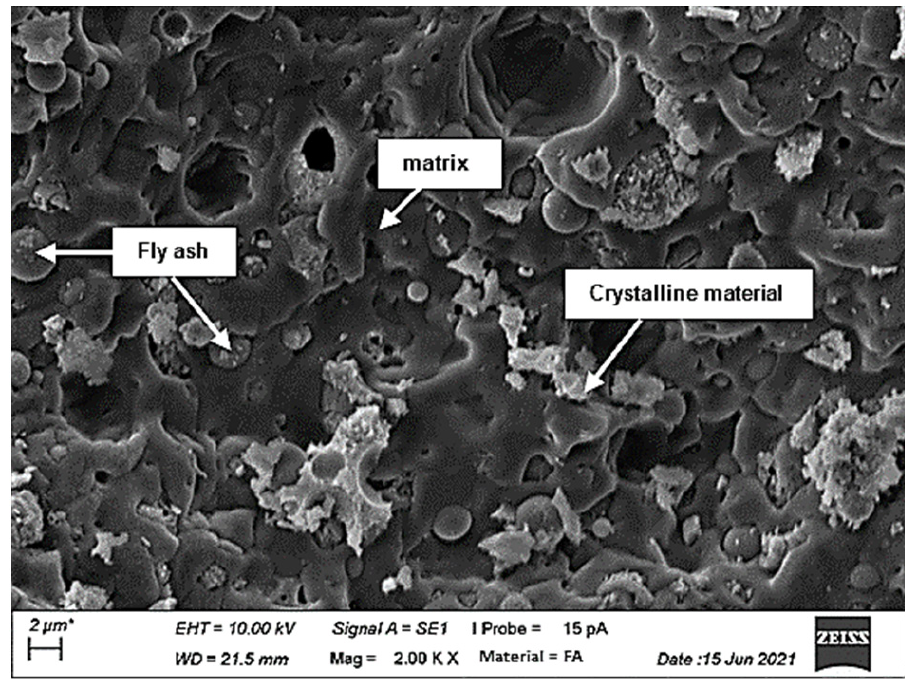
Figure 14. SEM image of the fracture surface of the fly ash geopolymer at 2000× magnification.